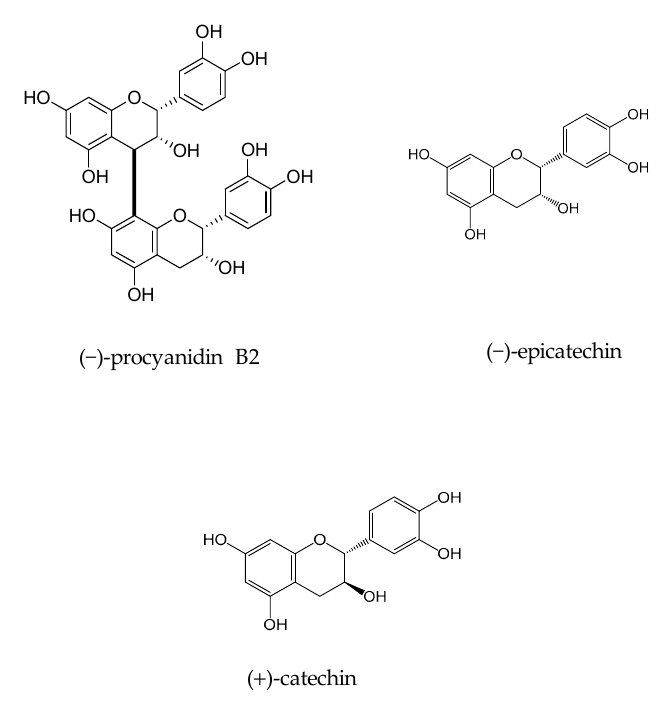
Figure 3. Structures of isolated constituents from Banisteriopsis caapi .